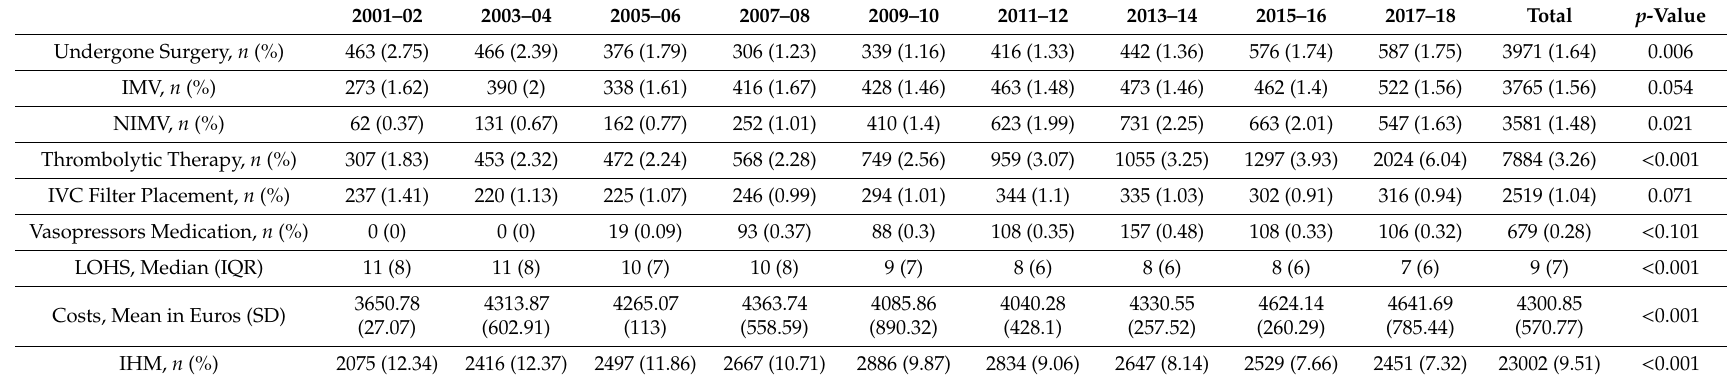
Table 3. Procedures and in-hospital outcomes for patients hospitalized with pulmonary embolism in Spain from 2001 to